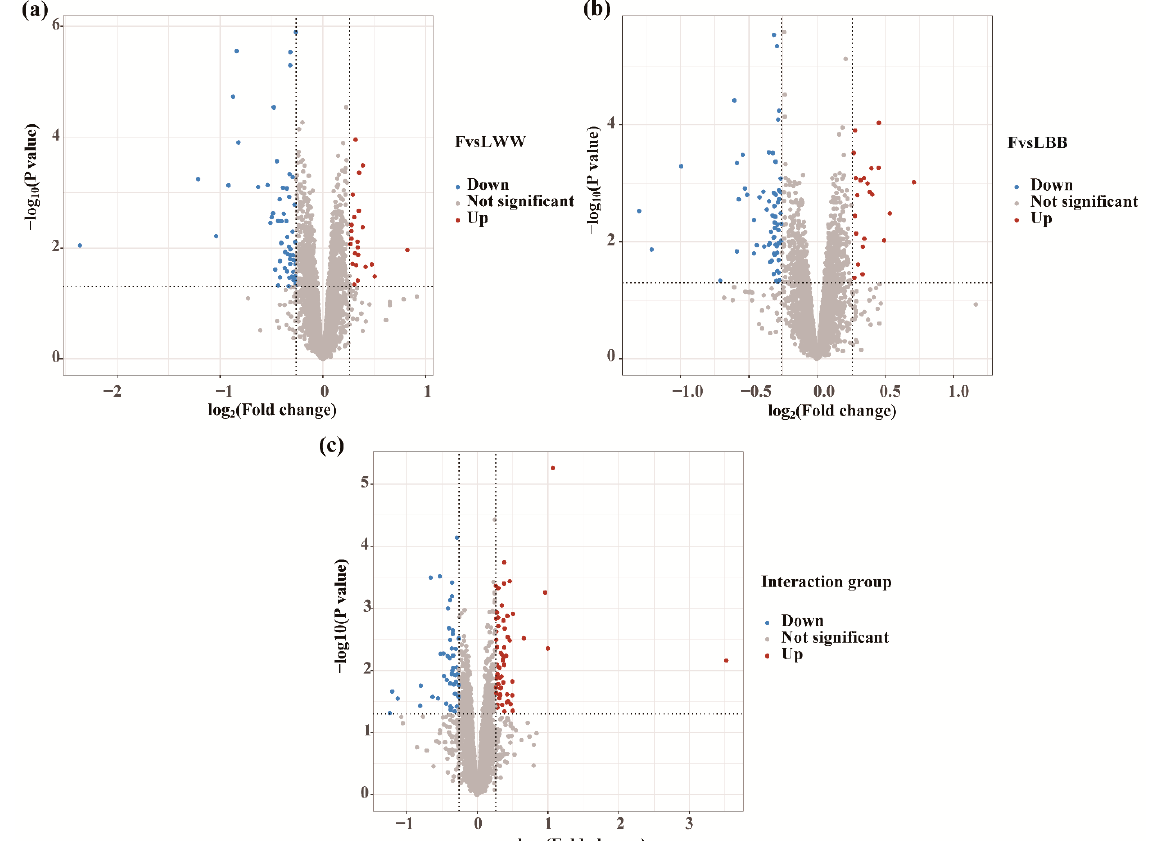
Figure 3. Volcano plots of DAPs. Using a foldchange >1.2 or <0.83, p value <0.05 as the threshold, the upregulated and downregulated DAPs are shown separately in the FvsLWW group ( a ), the FvsLBB group ( b ) and the interaction group ( c ). FvsLWW: follicular phase relative to the luteal phase in sheep with WW genotype; FvsLBB: follicular phase relative to the luteal phase in BB sheep; Interaction: which proteins respond differently in BB compared to WW sheep.